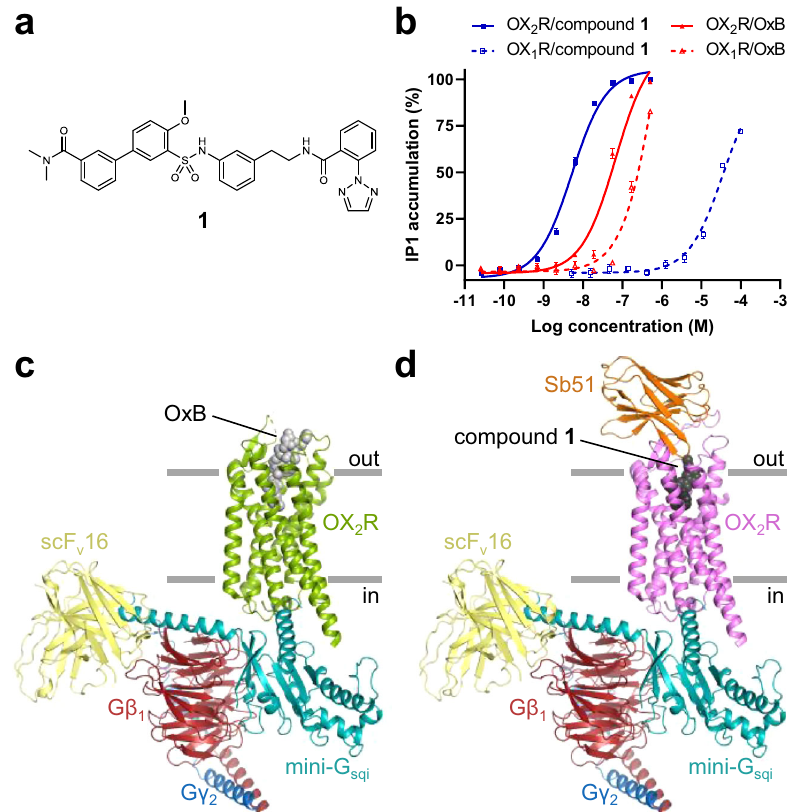
Fig. 1 Overall structures of peptide agonist and small-molecule agonist-activated OX 2 R. a Structural formula of the small-molecule orexin agonist used in this study. b Concentration-dependent activation of OX 1 R and OX 2 R by OxB and compound 1 . Half maximal effective concentrations represented as pEC 50 are: 4.45 ± 0.06 (OX 1 R – compound 1 ), 8.28 ± 0.03 (OX 2 R – compound 1 ), 6.09 ± 0.14 (OX 1 R – OxB), and 7.17 ± 0.07 (OX 2 R – OxB); error bars represent the standard error of the mean of n = 4 independent experiments for all except for OX 1 R/compound 1 , for which n = 5 independent experiments were performed. Data are presented as mean values ± s.e.m. c , d Structures of nucleotide-free OX 2 R – G-protein complexes bound to OxB and compound 1 , respectively, color-coded by subunit. Source data are provided as a Source Data fi